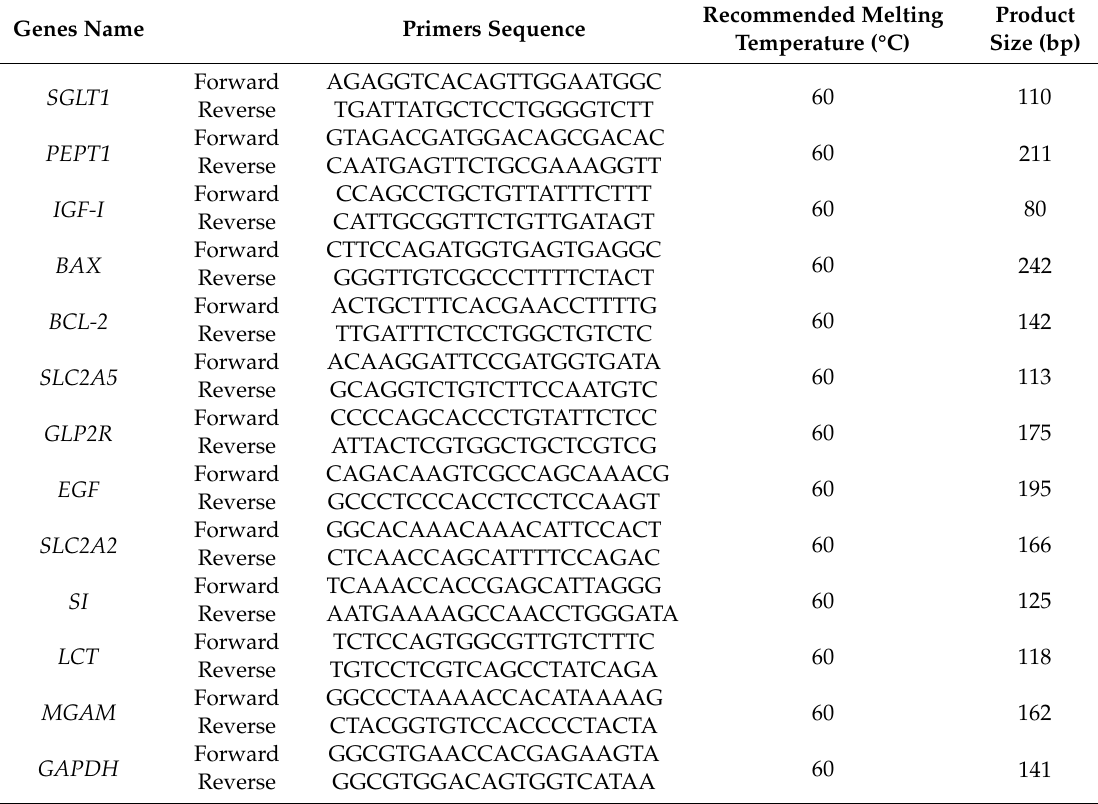
Table 2. Primers sequence of fluorescence quantitative